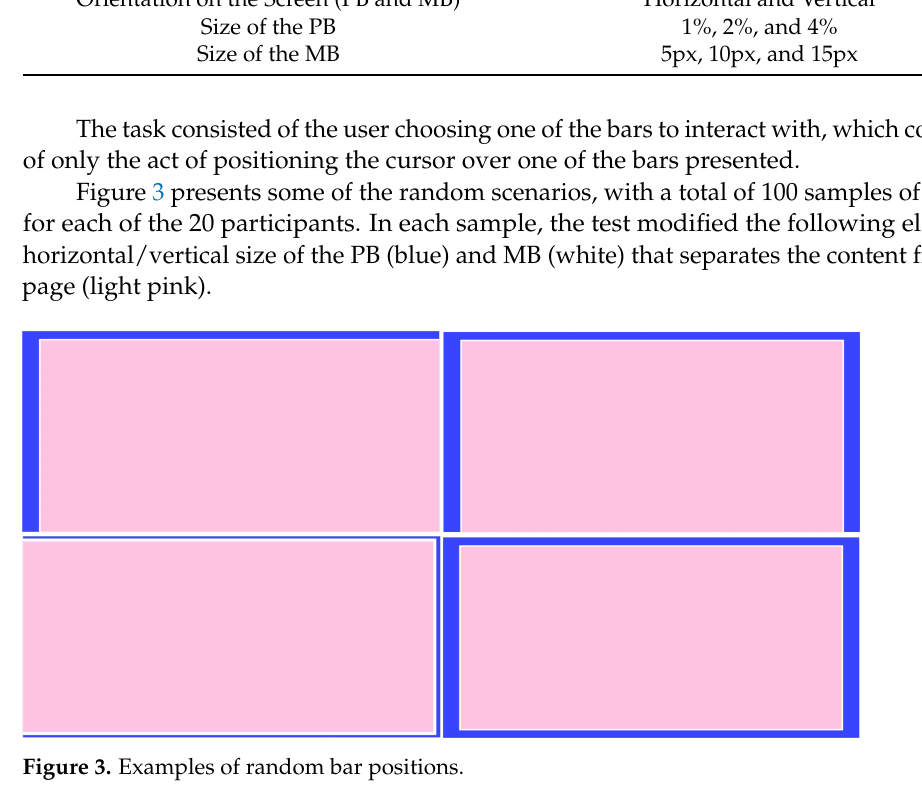
Table 3. Elements and values used in the first stage of tests. Elements Values Number of Bars on the Screen 2, 3, or 4 Position on the Screen (PB and MB) Left, Right, Up, and Down Orientation on the Screen (PB and MB) Horizontal and Vertical Size of the PB 1%, 2%, and 4% Size of the MB 5px, 10px, and 15px